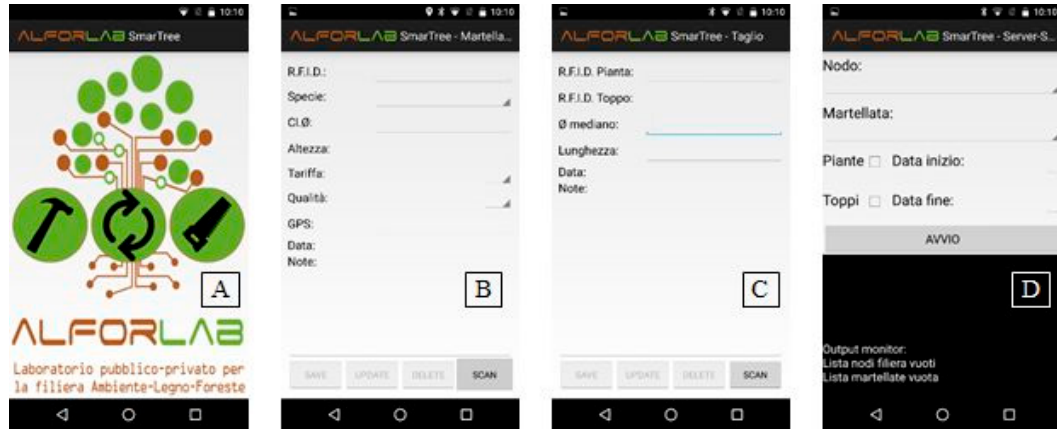
Figure 6. ( A ) Main activity of the SmartTree app (written in Italian to be used by local operators); ( B ) Activity of the timber marking form [Species (Specie), Diametric class (Cl. Ø), Height (Altezza), Tariffs (Tariffa; from 1 to 9), Quality (Qualità; A, B, C, D), GPS (automated inserted and unmodifiable), Date (Data; automated inserted and unmodifiable), Note]; ( C ) Activity of the cutting form [Median Diameter (Ø mediano), Length (Lunghezza), Date (Data; automated inserted and unmodifiable), Note]; ( D ) Activity of the synchronization phase with the remote server and blockchain. The app was developed to be used by Italian users [Node (Nodo), Timber marking (martellata), Ttree (Piante), Logs (Toppi), Start date (Data inizio); End date (Data fine)].